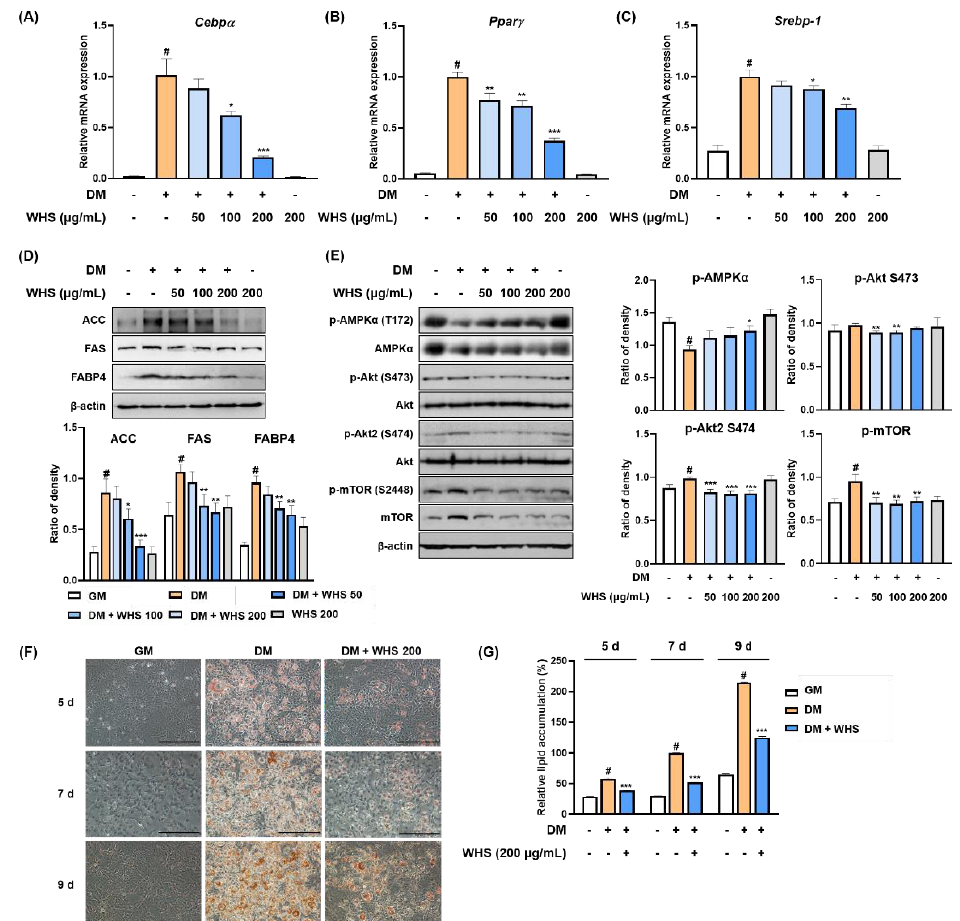
Figure 1. Anti-adipogenic effect of water extract of Hydrangea serrata (Thunb.) Ser. leaves (WHS) mediated by the regulation of the AMPK and Akt/mTOR pathways in 3T3-L1 preadipocytes. Cells were differentiated into adipocytes in the presence or absence of WHS (50, 100, or 200 μg/mL). ( A – C ) The mRNA expression levels of Cebpα , Pparγ , and Srebp-1 were analyzed by qRT-PCR. ( D , E ) Western blot analysis was performed to determine the expression levels of ACC, FAS, and FABP4, and the activation of the AMPK and Akt/mTOR signaling pathways. ( F ) Representative microscopic images and ( G ) the quantified contents of intracellular lipid accumulation. Values are expressed as the mean ± SD. # p < 0.05 vs. GM control group; * p < 0.05, ** p < 0.01, and *** p < 0.001 vs. DM control group.